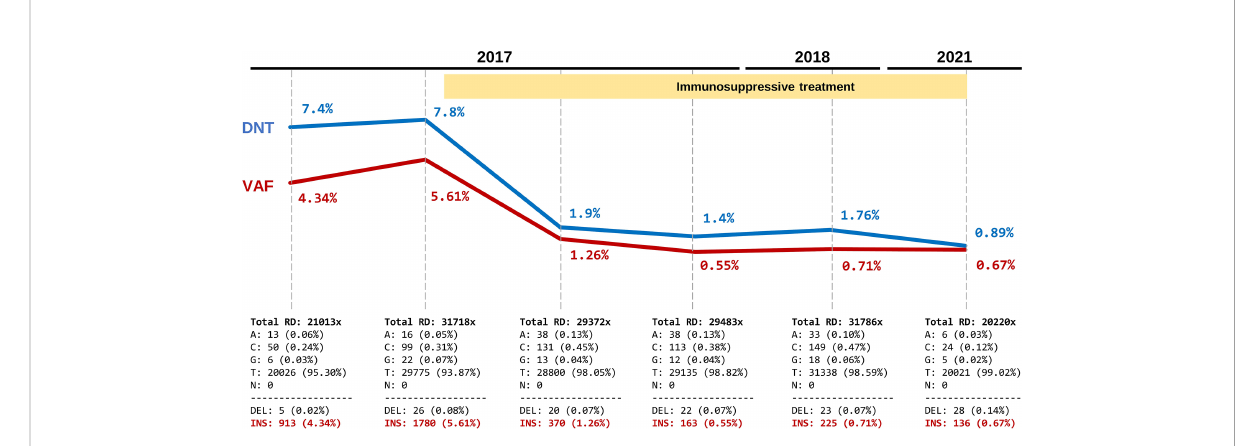
FIGURE 2 Evolutionary dynamics of the somatic FAS variant and correlation with DNT percentages during a fi ve-year follow up. Each time point shows the TCR ab + CD4 - CD8 - T cells (DNTs) (in blue) and variant allele frequency (VAF) of the pathogenic somatic FAS variant (c.718_719insGTCG) (in red). The yellow shading indicates the sirolimus treatment period. The bottom panels show the absolute values and percentage of read counts supporting each allele in the position of the variant c.718_719insGTCG (values were extracted from IGV data after quality fi ltering). Total RD, Total read